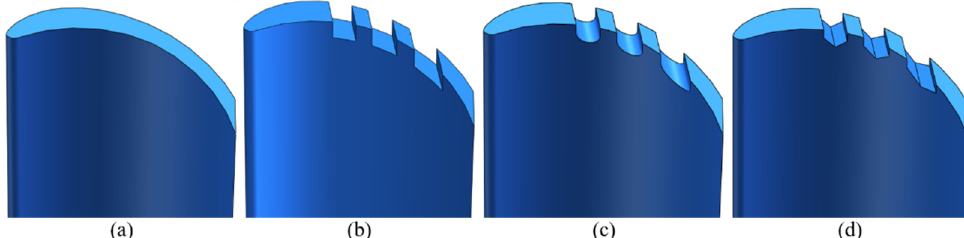
Figure 10. Parametric model of blade tip with different grooved shapes: ( a ) blade tip of original fan, ( b ) blade tip with RBGs, ( c ) blade tip with CBGs, and ( d ) blade tip with TBGs. ( b ) blade tip with RBGs, ( c ) blade tip with CBGs, and ( d ) blade tip with